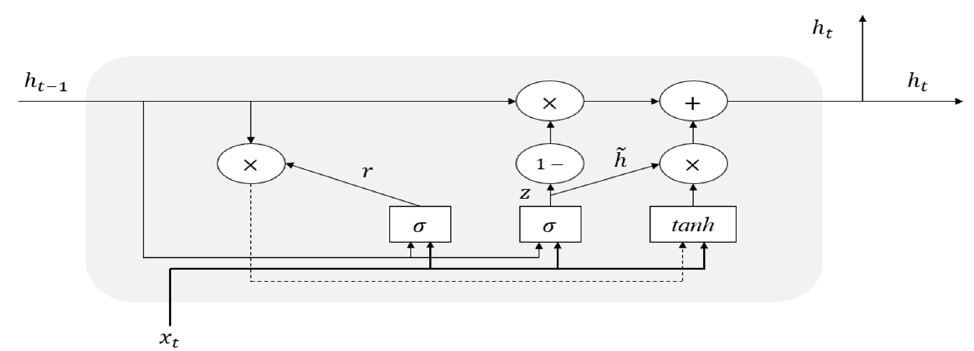
Figure 8. Structure of Gated Recurrent Units (GRU).